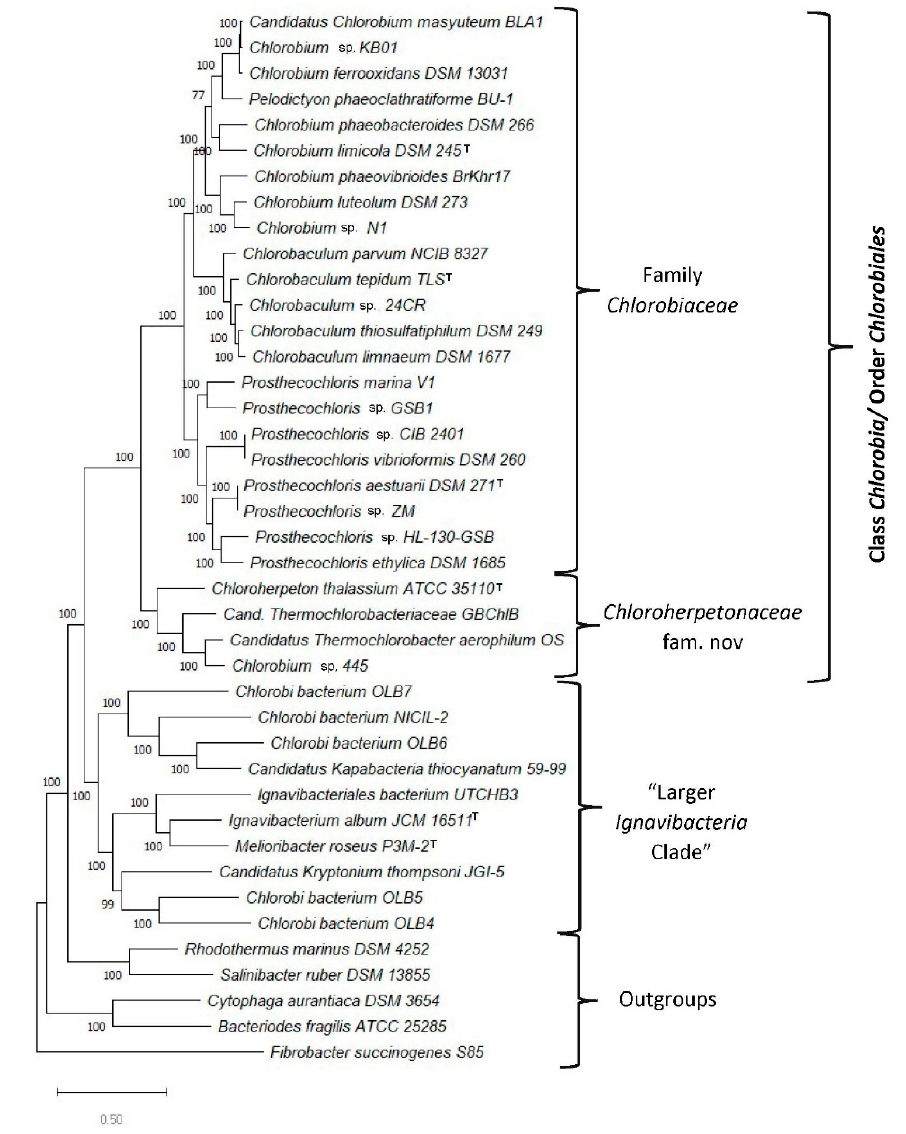
Figure 1. A bootstrapped maximum-likelihood tree for different genome-sequenced Chlorobia/Ignavibacteria and related species/strains based on concatenated sequences for 282 conserved proteins that are core proteins for these species. Statistical support values for different branches are indicated on the nodes. The tree was rooted using the sequences from the species Fibrobacter succinogenes. The type strains of different species are marked by the superscript T . Some species clades observed in this tree are marked.